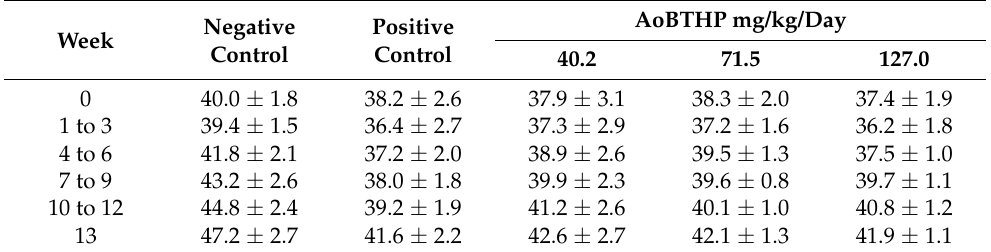
Table 2. Weekly mean body weight per group of animals during the study (mean ± SEM). Week